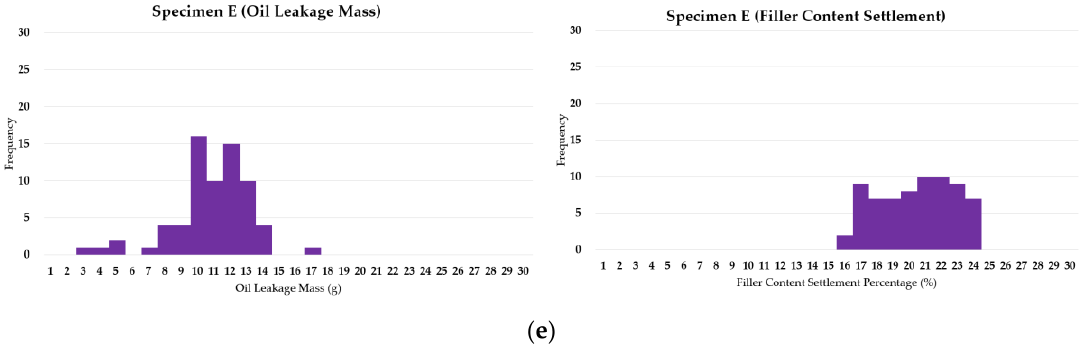
Figure 11. Normative distribution of the probability density calculation of the average oil leakage mass and filler content settlement ratio (left: oil leakage mass, right: filler content settlement); ( a ) specimen A, ( b ) specimen B, ( c ) specimen B, ( d ) specimen D, ( e ) specimen E.